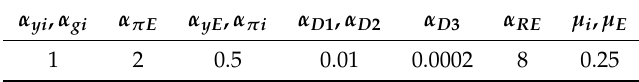
Table 1. Weights of the variables in the objective functions.